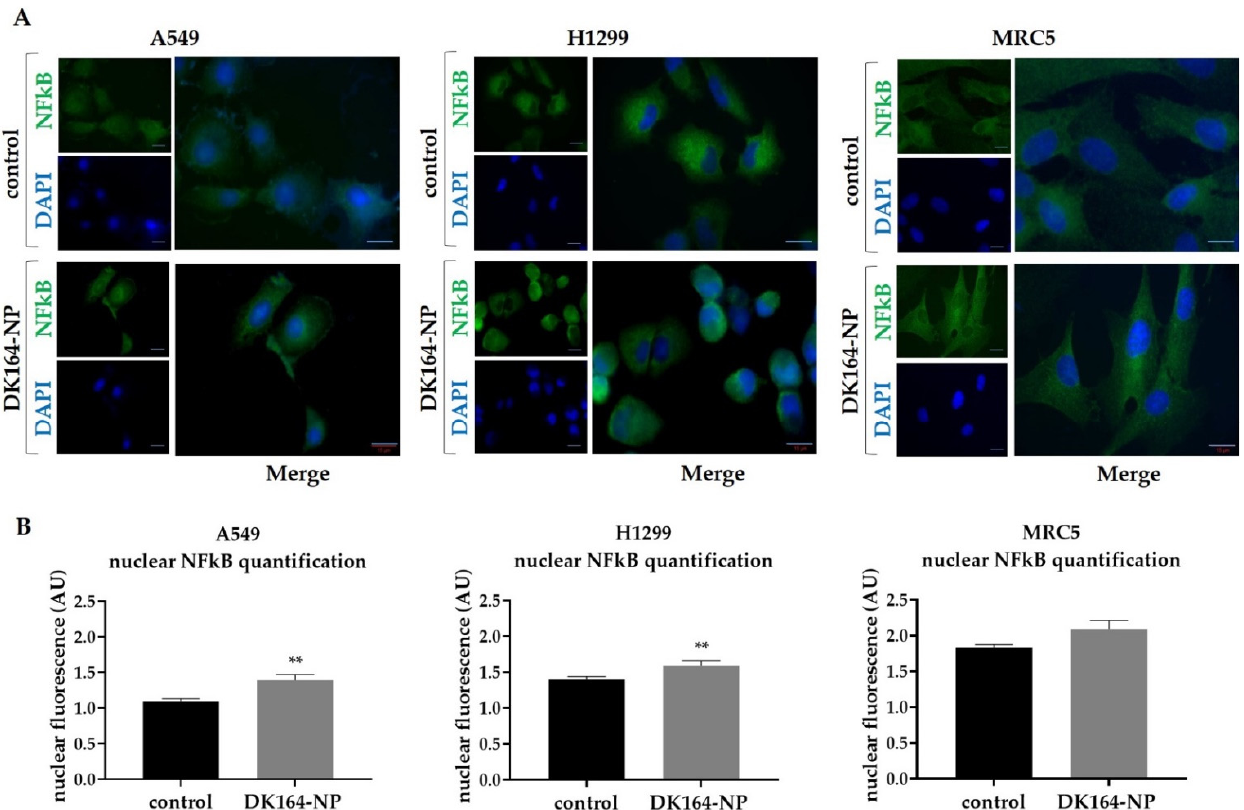
Figure 8. Activation and nuclear translocation of the NFkB protein in lung cells. ( A ) Representative immunofluorescent images of A549, H1299, and MRC5 control cells and cells treated with the calculated IC50 concentrations of DK164-NP for 48 h and labeled with anti-NFkB antibody (green). DNA was co-stained with DAPI (blue); ( B ) Quantitative determination of the intensity of the nuclear NFkB-signal, normalized with nuclear DNA content, was performed by CellProfiler cell image analysis software (Broad Institute’s Imaging Platform, Cambridge, MA, USA) and GraphPad Prism v.8.0 (Dotmatics, San Diego, CA, USA). A p -value < 0.05 was considered statistically significant, ** p < 0.01. Quantification is based on three independent experiments with >50 cells scored for each condition. The error bars represent standard deviation (SD). AU: arbitrary unit. Scale bars represent a distance of 15 µm.